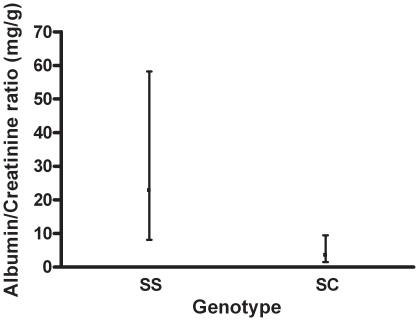
Albumin/creatinine ratios with SDs for SS and SC genotypes.Values are geometric means with 95% confidence intervals.